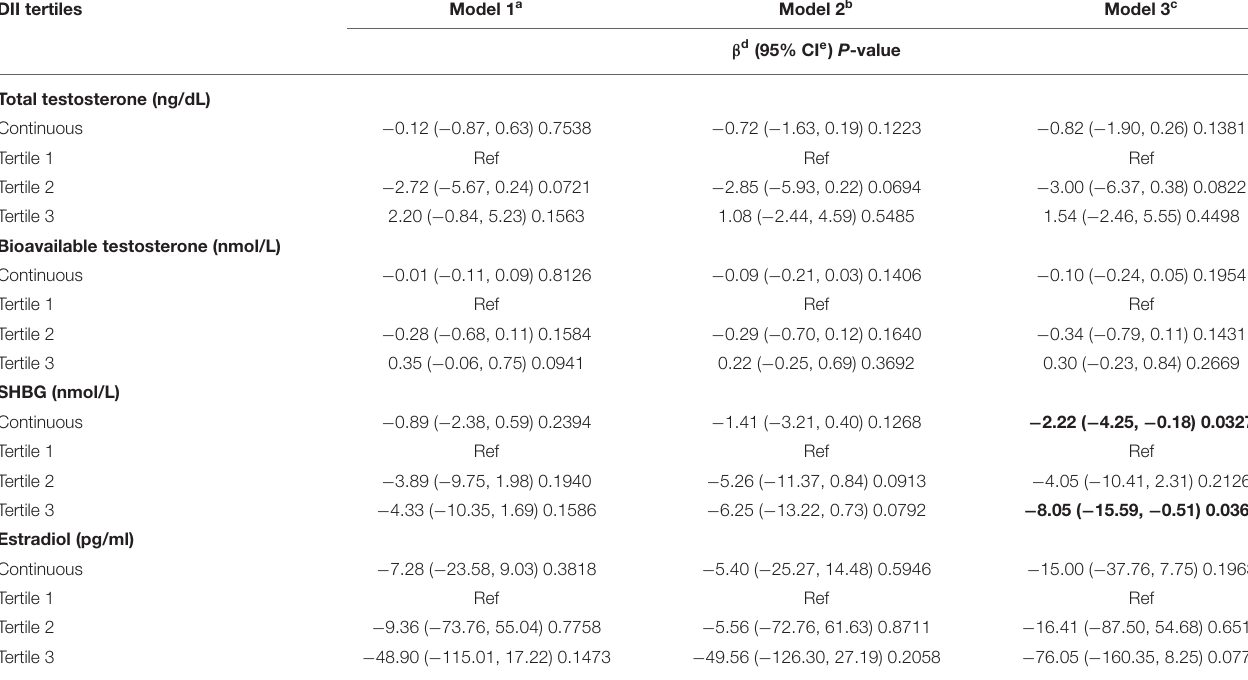
TABLE 2 | The association between dietary inflammatory index and sex hormone & sex hormone binding